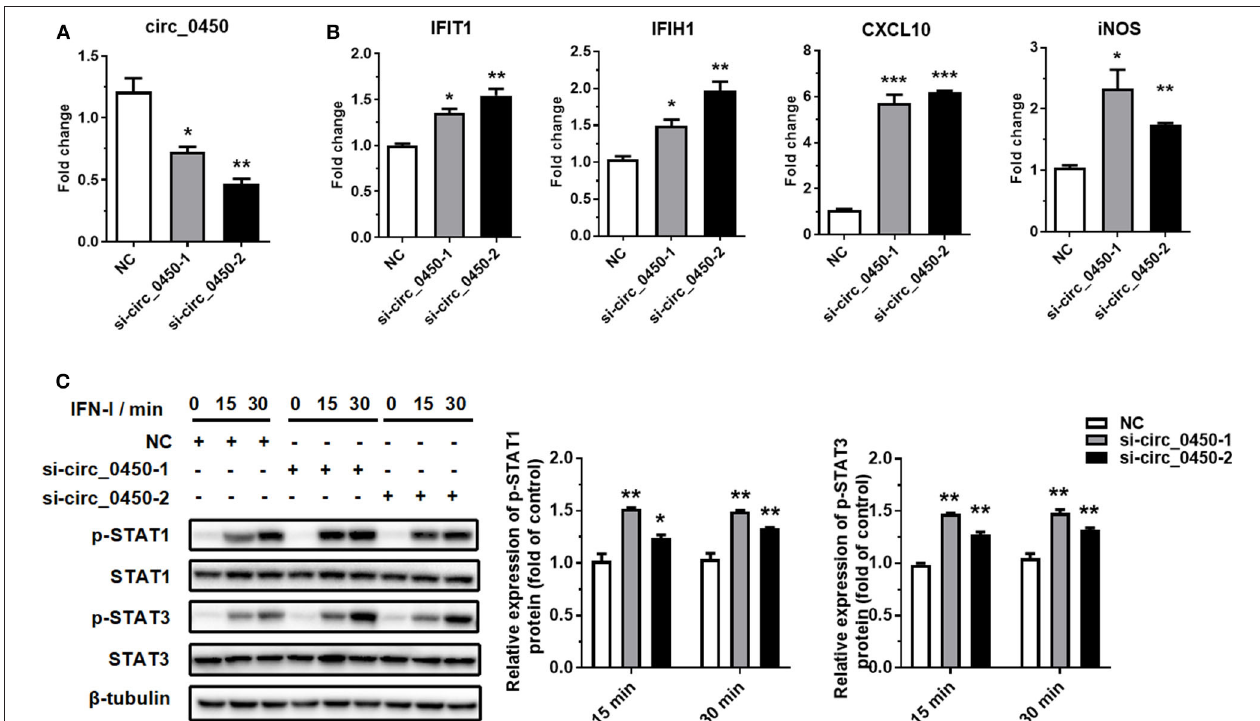
FIGURE 2 | Silencing of hsa_circ_0060450 promotes IFN-I-induced inflammation through the JAK-STAT1/3 pathway. (A) RT-qPCR analyses of hsa_circ_0060450 to confirm the silencing efficiencies of two siRNAs. (B) RT-qPCR analyses of IFIT1 , IFIH1 , CXCL10 , and iNOS under IFN-I stimulation after treatment with two hsa_circ_0060450 siRNAs. (C) STAT1 and STAT3 protein phosphorylation assessment at 15 and 30min of IFN-I stimulation after treatment with two hsa_circ_0060450 siRNAs. NC, negative control. Data represent means ± SEM. * p < 0.05, ** p < 0.01, *** p <